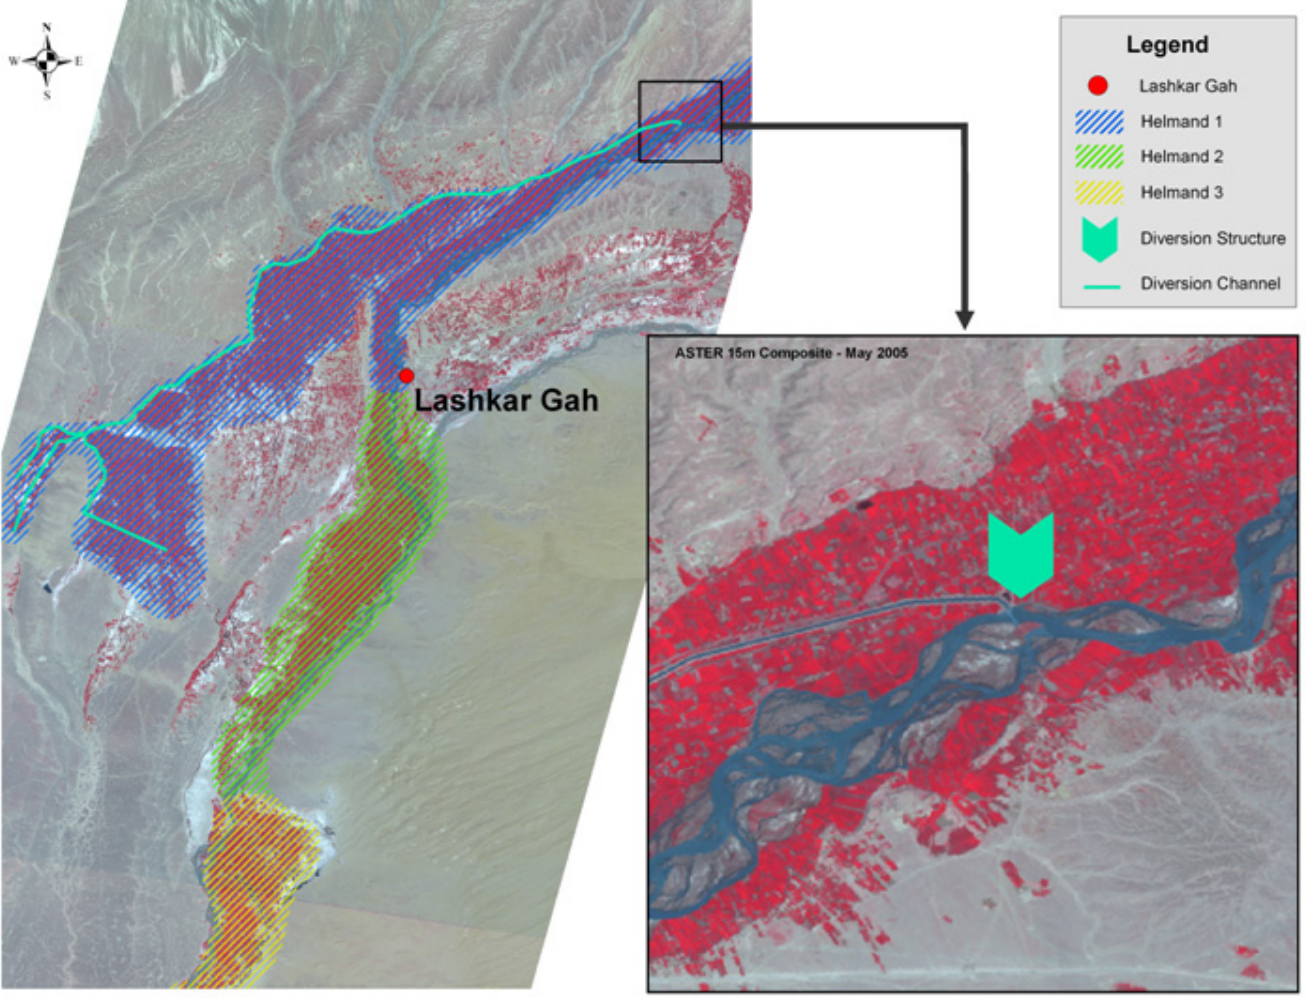
Figure 13. Location of a diversion structure on the Helmand River upstream of Lashkar Gah. The diversion channel is visible in the enlarged portion of the 15-m ASTER image above (right). The extent of the channel runs along the northern section of the Helmand 1 area, west of Lashkar Gah, and is highlighted in the image on the